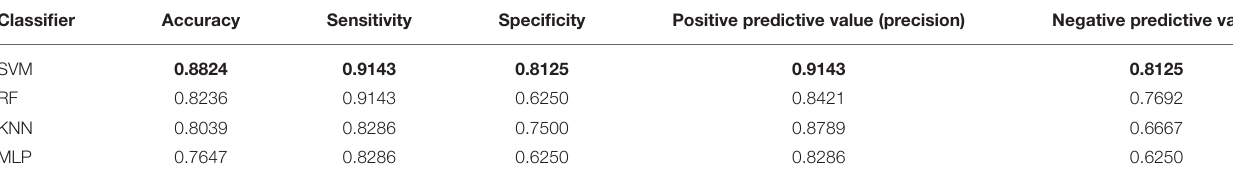
TABLE 2 | Evaluation of the performances of different ML